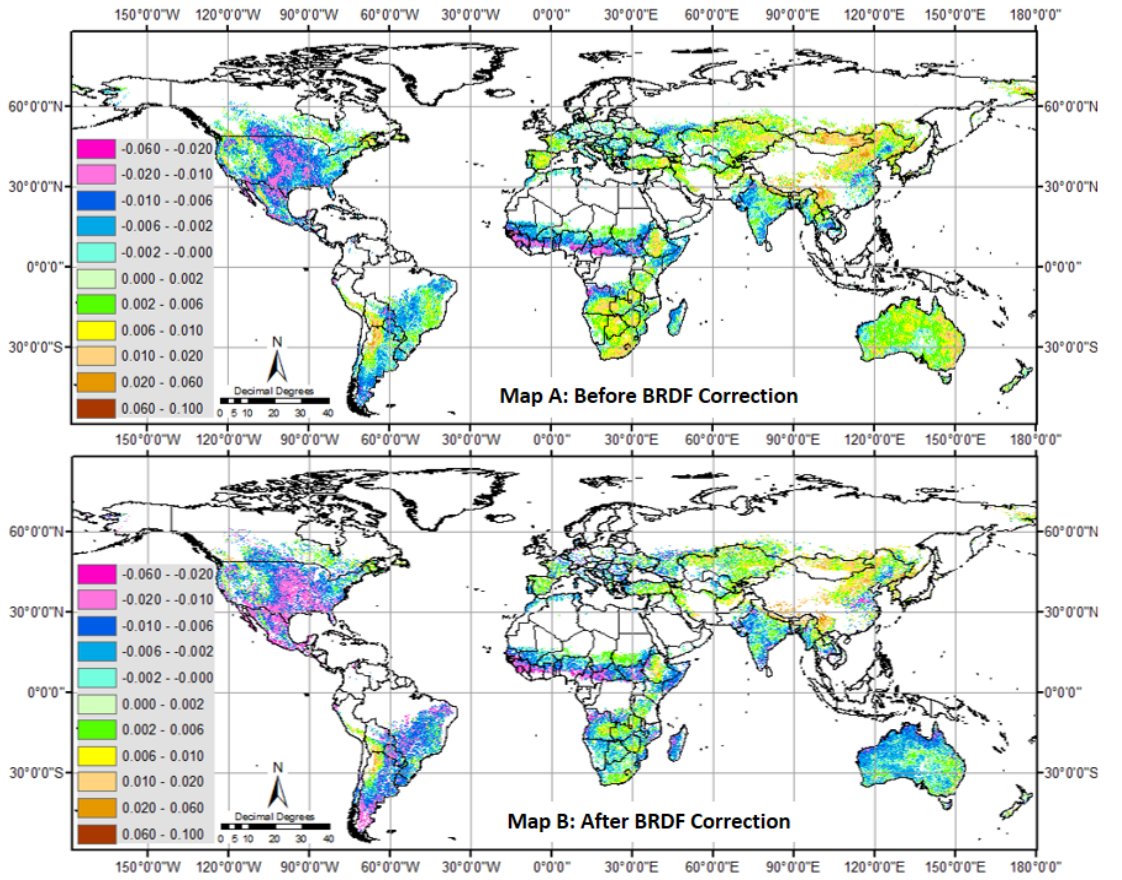
Figure 2. Map A : Orbital drift related spurious inter-annual trends in AVHRR NDVI data before BRDF correction; Map B : Orbital drift related spurious inter-annual trends in AVHRR NDVI data after BRDF correction. The magnitude of spurious inter-annual trends were estimated as the inter-annual trend of AVHRR and MODIS NDVI differences (AVHRR NDVI—MODIS_Aqua NDVI) as described in Figure 1. The mean global spurious inter-annual NDVI trend before and after BRDF correction was 0.0016 and − 0.0017 respectively. Deserts, urban areas, wetlands, and the pixels with less than 30 data points were excluded from the